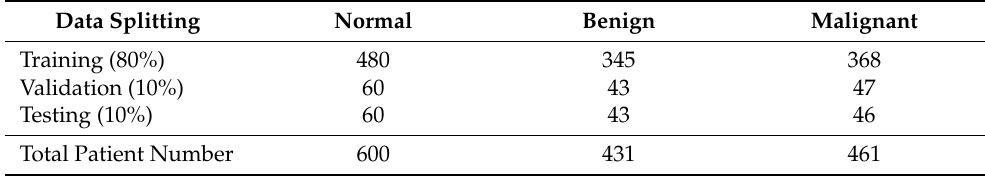
Table 2. Scenario B (Multi-class Classification) data splitting training, validation, and testing. Data